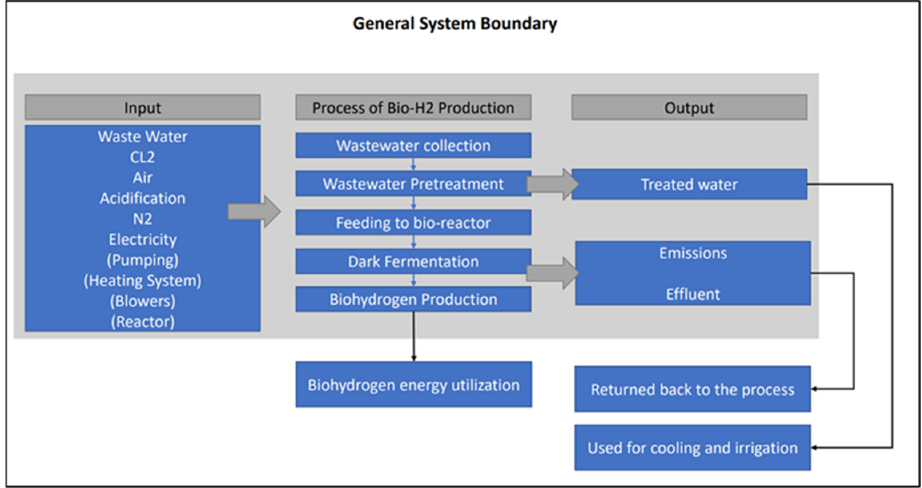
Figure 5. General system boundary of the system.